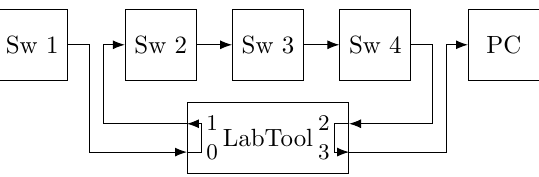
Figure 13. Topology used to measure the end-to-end delay in the absence of faults.